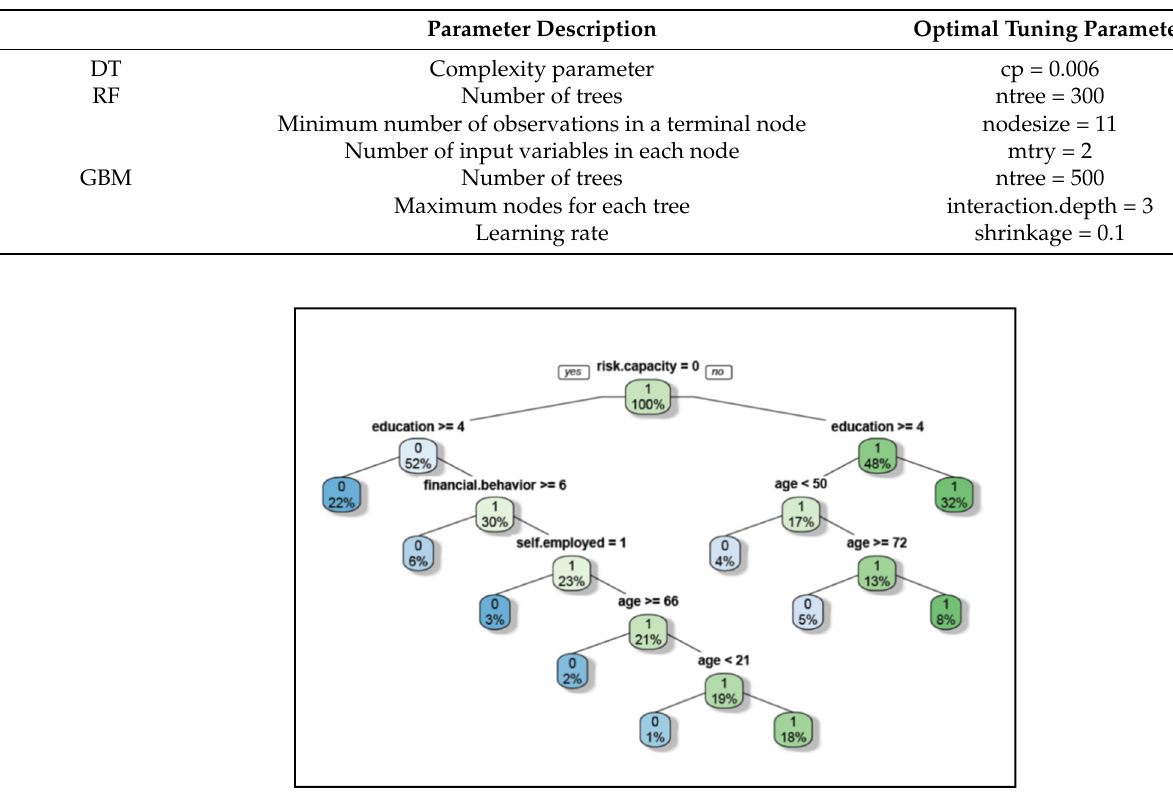
Figure A1. Decision tree for FL.